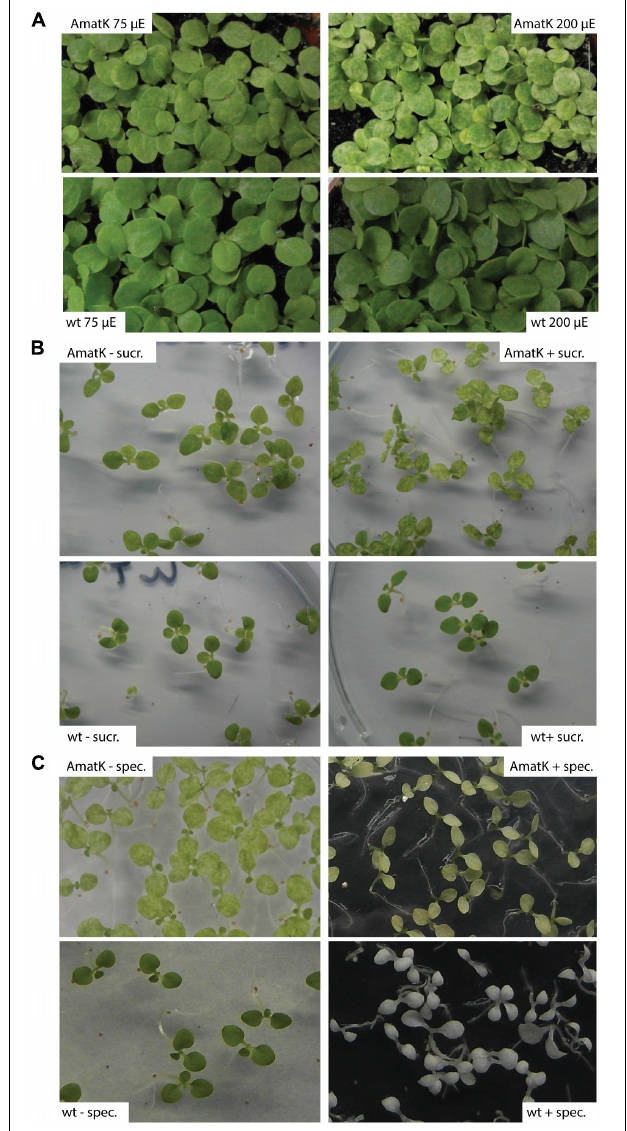
FIGURE 2 | AmatK variegation is modified by light, sugar and translation inhibition. (A) AmatK and wt plants germinated under two light regimes and photographed after 10 days. (B) AmatK and wt plants germinated on MS media with or without a sucrose supplement (3%w/v). (C) AmatK and wt plants germinated on MS media with or without a spectinomycin supplement (500 µ g/L).